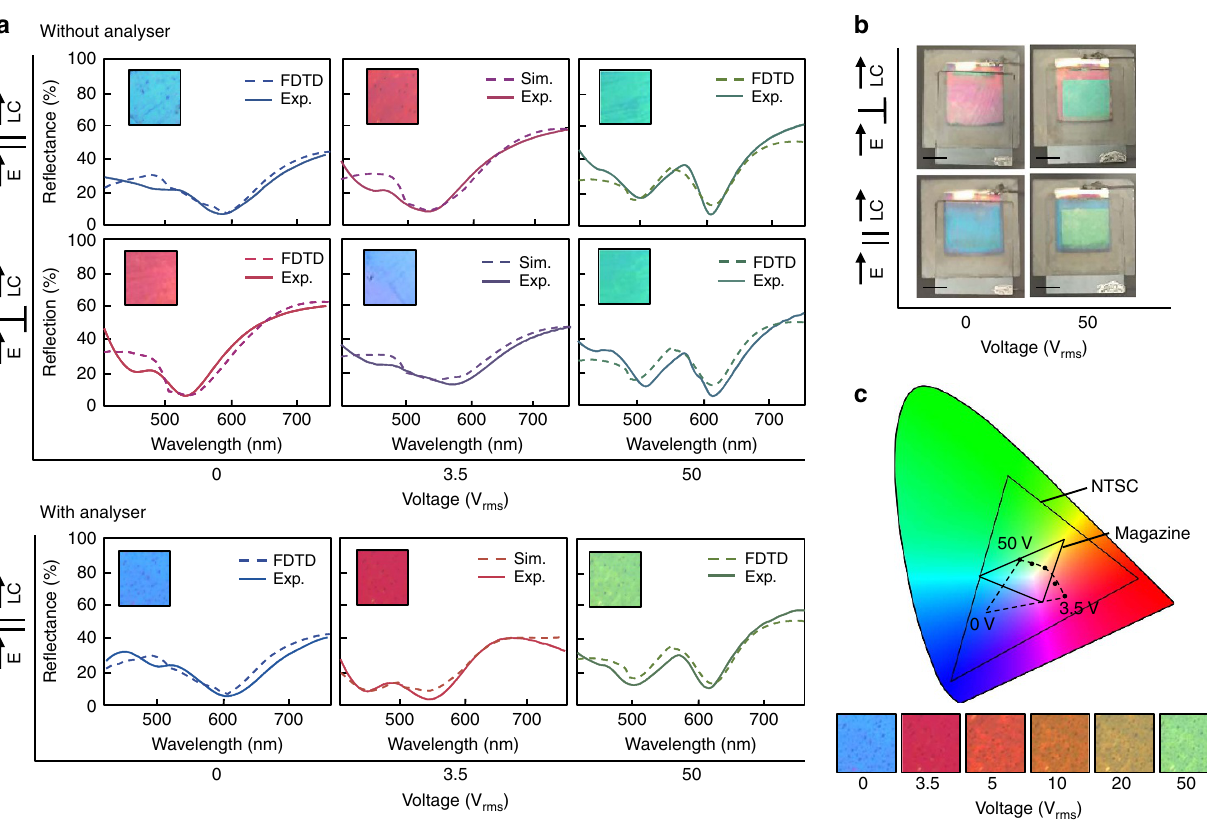
Figure 4 | Full Red–Green–Blue colour and analyser dependence. ( a ) Measured and simulated reflection spectra of the surface as a function of applied field and input polarization. The last row shows the influence of an added analyser parallel to the input polarizer. Insets show microscope images of the surface. Line colours are determined by the CIE colour matching functions. ( b ) Camera images of the device at selected polarizer orientations and voltage. Samples are 1in (cid:4) 1in. ( c ) The CIE chromaticity diagram showing the colour space of the liquid crystal-plasmonic system and that of comparative standards. Below are microscope images of the surface at increasing applied fields. Scale bars, ( b ) 0.5